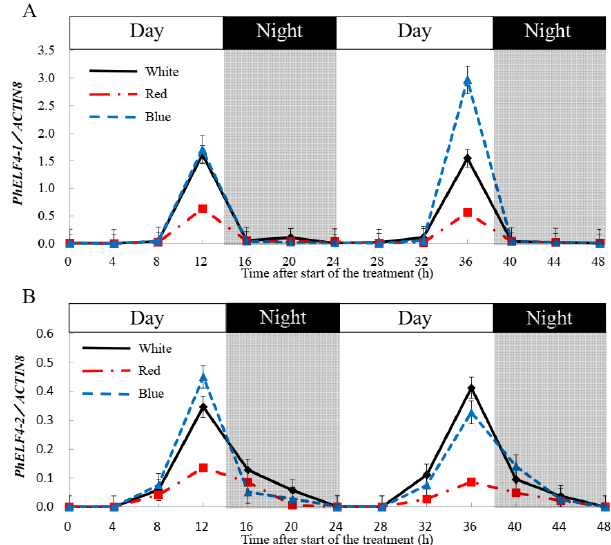
Figure 3. Diurnal expression of PhELF4-1 ( A ) PhELF4-2 ( B ) in young leaves of petunia plants the first and second day of exposure to white fluorescent light or blue or red light from light emitting diodes under long days of a 14 h photoperiod, as analyzed by real-time quantitative PCR. White and black bars at the top of the graph indicate light (day) and dark (night) periods, respectively. The expression was normalized to the expression of the PhACTIN 8 gene. The error bars show SE ( n =